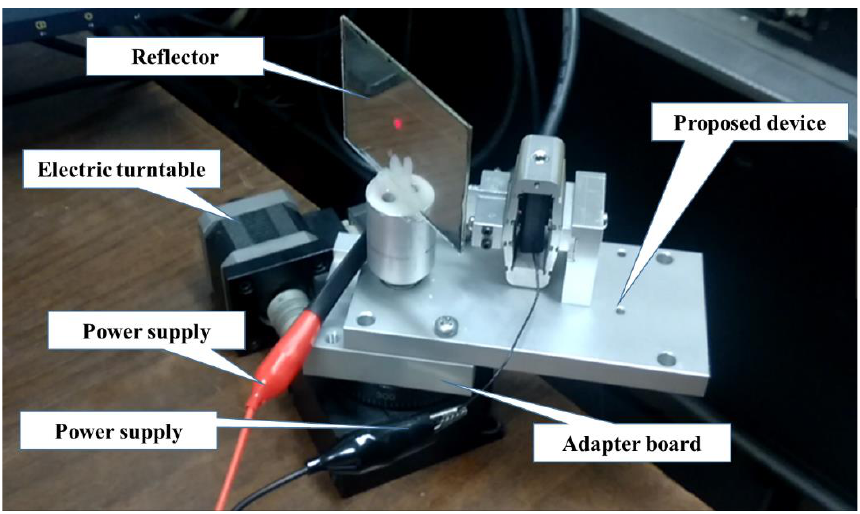
Figure 10. The experimental setup of the velocity matching experiment.